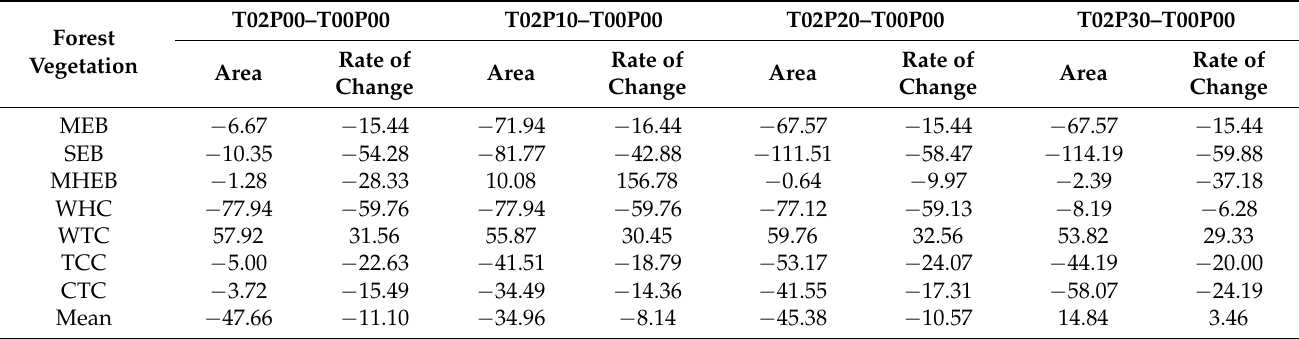
Table 4. Rate of change in the forest distribution area under scenarios with a temperature increase of 2 ◦ C and different decreases in precipitation. Units: Area, × 10 5 ha; Rate of change, %.